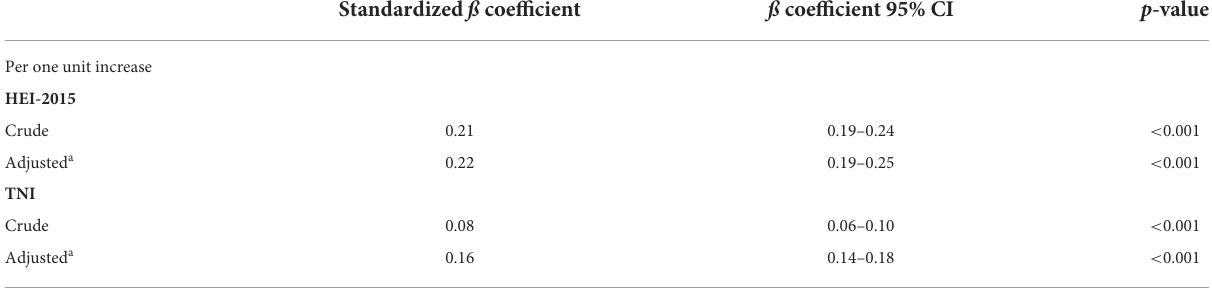
TABLE 4 Association between HEI-2015, TNI, and %E P:C